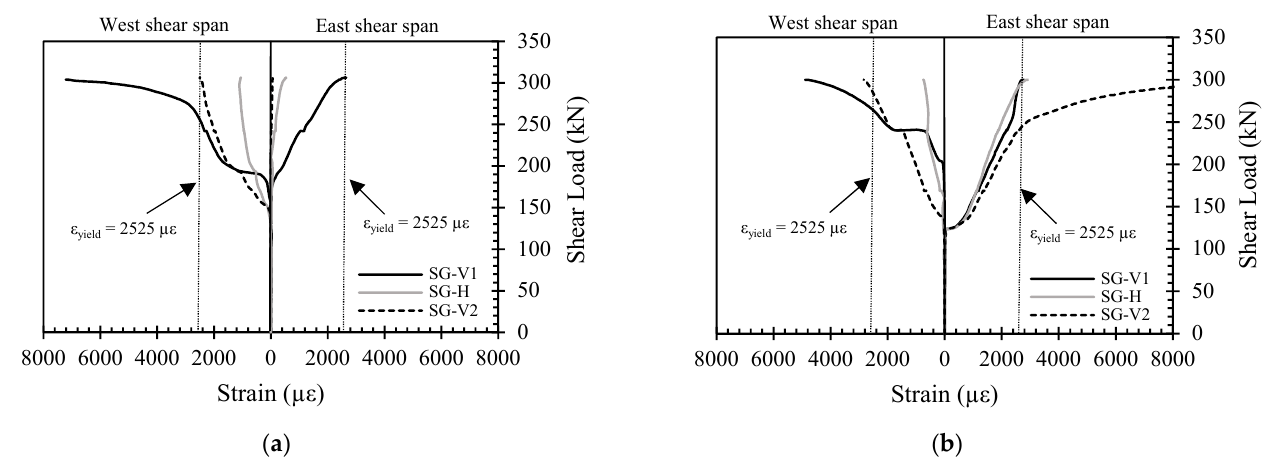
Figure 6. Shear load–stirrup strain response: ( a ) BR0-SF0-S; ( b ) BR100-SF0-S.